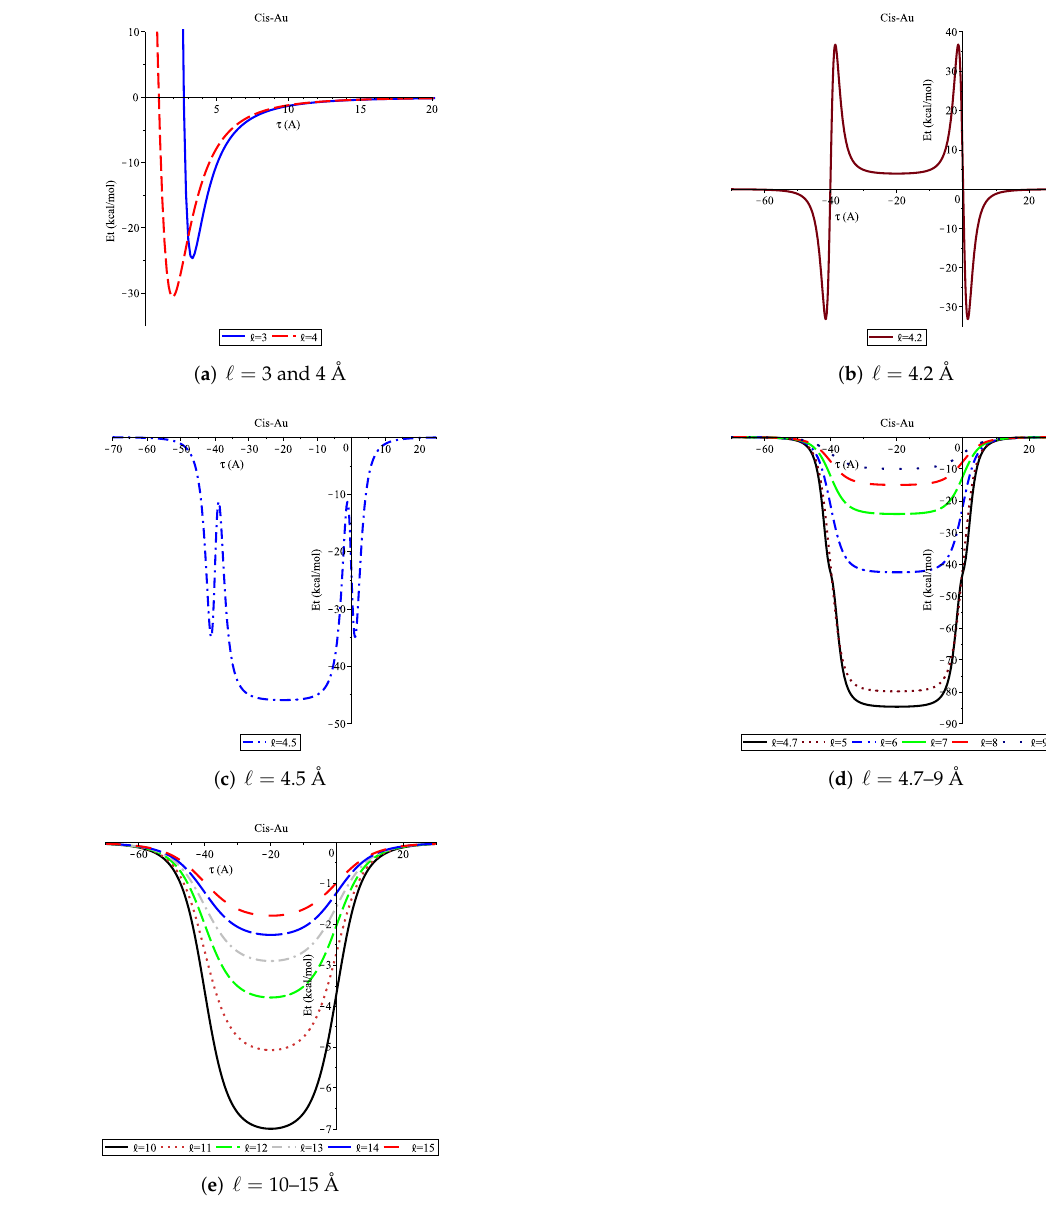
Figure 4. Energies of Cis molecule and Au nanopore of different radii (cid:96) with respect to the distance τ